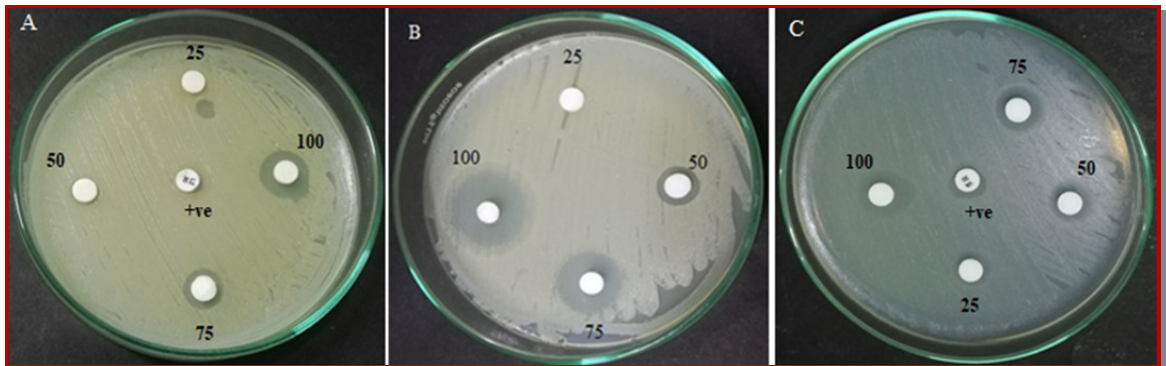
Figure 1: Antagonistic activity against vancomycin-resistant Enterococcus by dichloromethane (A), ethyl acetate extract of stem (B), and ethyl acetate extract of root (C)